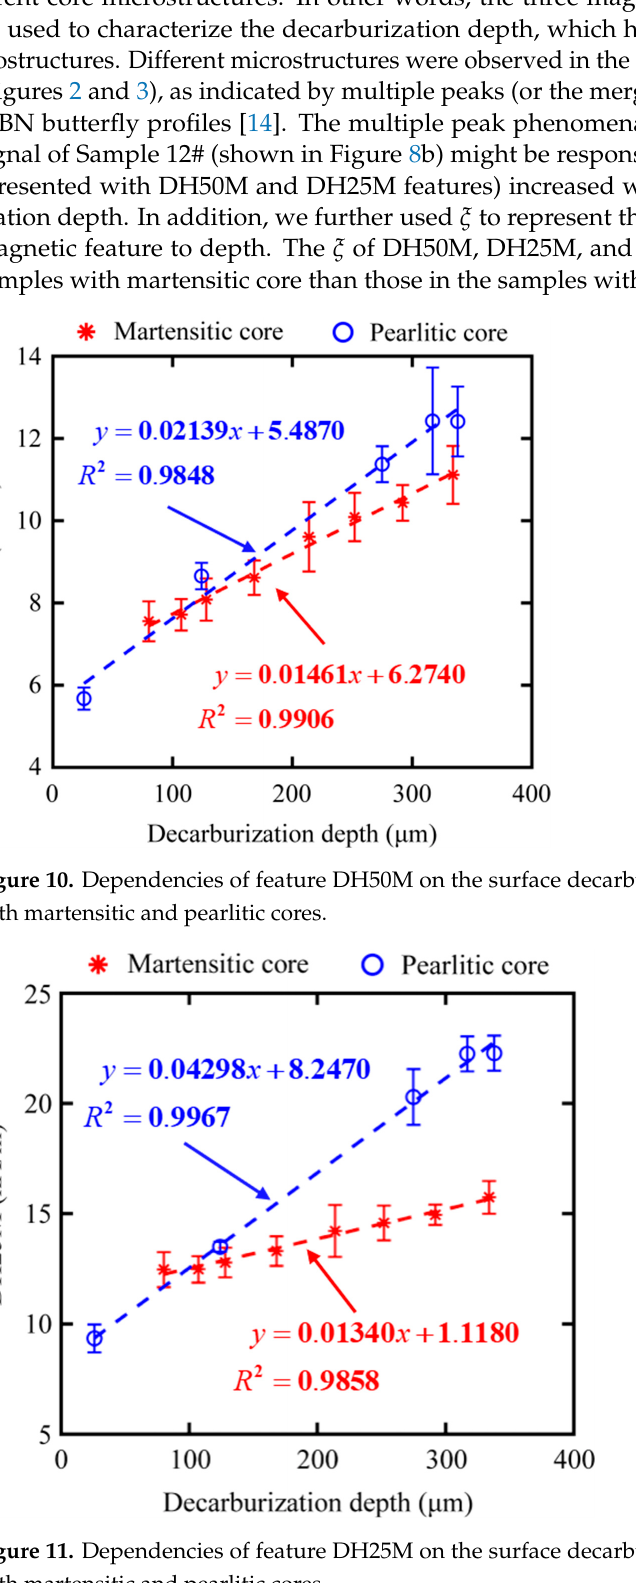
Figure 12. Dependencies of feature M rs on the surface decarburization depths for all samples with martensitic and pearlitic cores. 5. Conclusions In this paper, the ability of MBN to nondestructively characterize the decarburization depth of spring steel was investigated, and the effects of different core microstructures on the characterization ability of MBN were explored. The main results are summarized as follows: